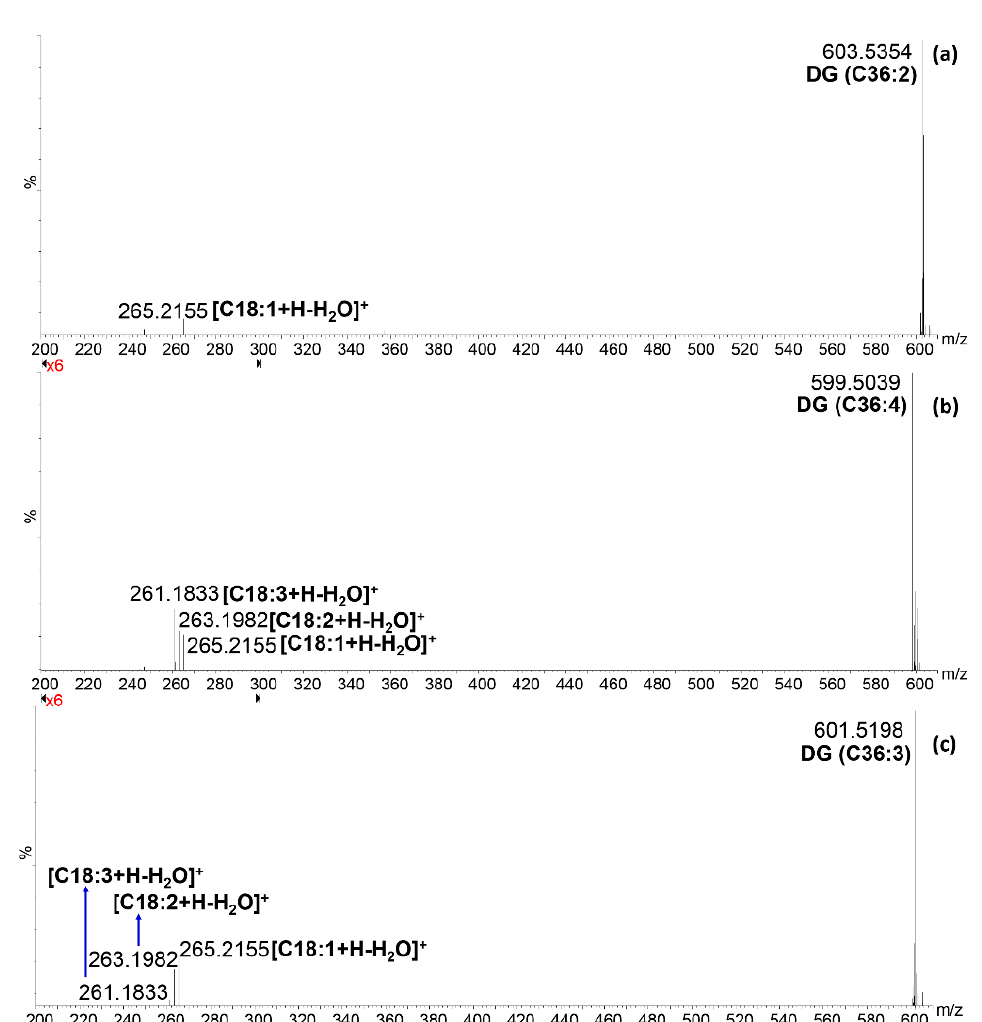
Figure 4. Tandem mass spectrometry (MS / MS) spectrum over the range 200–610 m / z of ( a ) m / z 603.52; ( b ) m / z 599.49; ( c ) m / z 601.50; obtained in positive ionization mode at a collision energy of 30 eV.